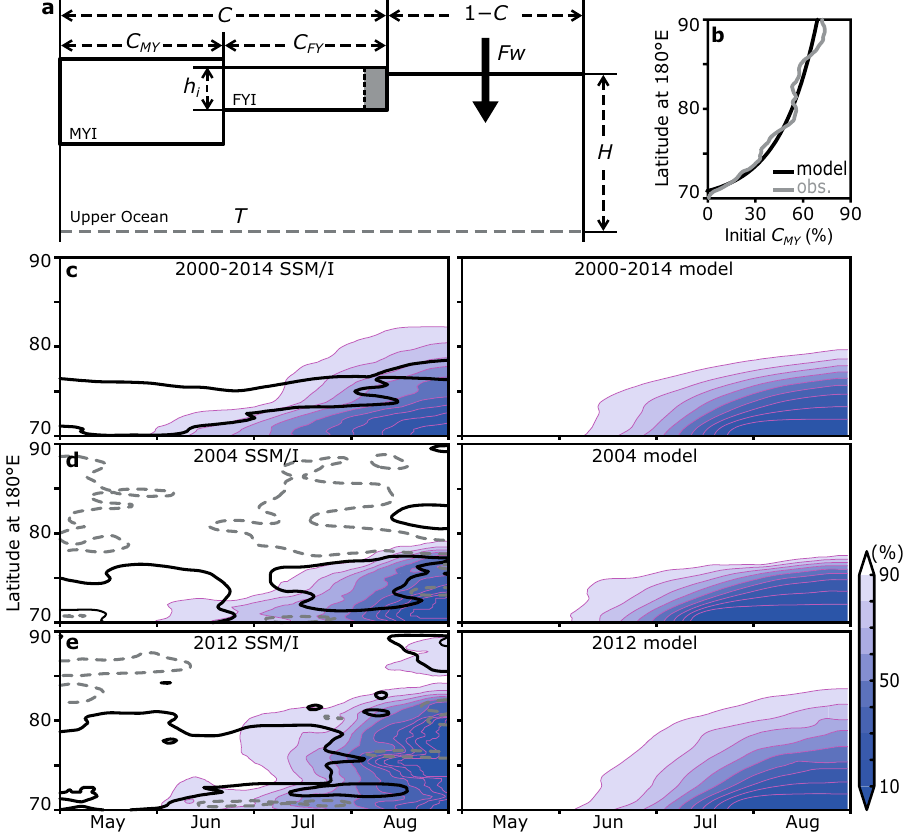
Figure 3. Results of the simplified model. ( a ) Schematics of the model. ( b ) Latitudinal distribution of multiyear ice ( C MY ) from satellite observations (gray line) and as used in the model (black line). ( c – e ) Meridional-time evolution of sea ice concentration obtained from satellite observations (left panels) and from the simplified model (right panels). Thick contours in left panels delineate cases when absolute sea ice divergence (solid black line) and convergence (dashed gray line) exceed 3% mo − 1 . Figures are drawn by GrADS 2.0.2 (available from